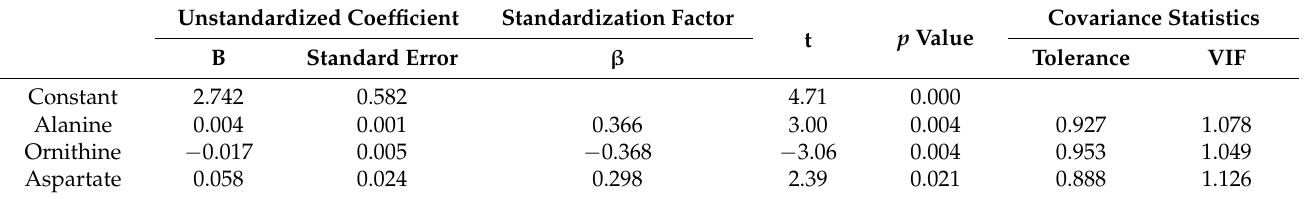
Table 5. Estimation of the final multiple linear regression for OPG in vegetarians ( n =